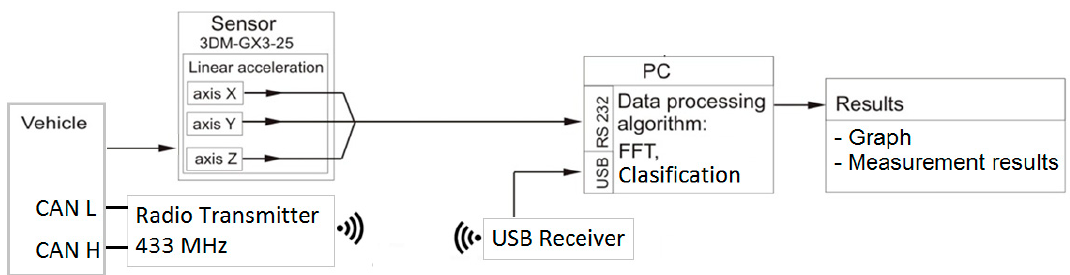
Figure 2. Placement of the 3DM-GX3-25 sensor on the vehicle during tests and block diagram of the measuring system.